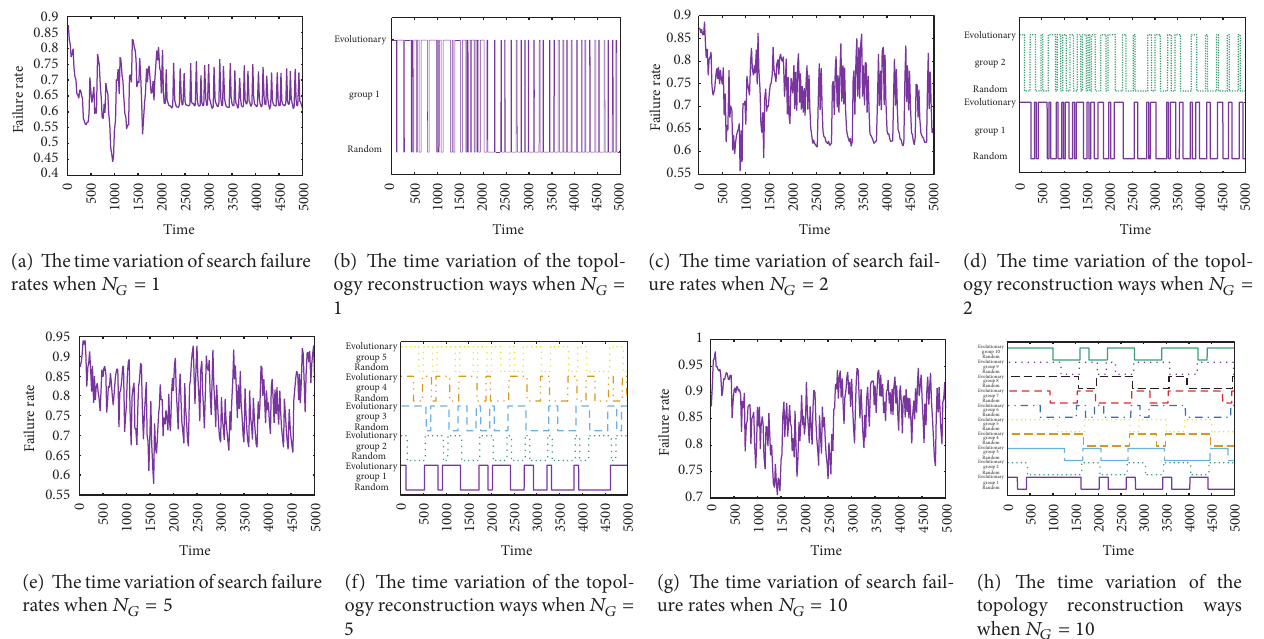
Figure 14: The result of one simulation run when using the simulation scenario that each node participates in the network with the probability randomly assigned in between 60% and 100% at every time and the environment dynamically changes. The time variations of search failure rates are drawn in the subfigures (a), (c), (e), and (g) and the time variations of the topology reconstruction ways are drawn in the subfigures (b), (d), (f), and (h). The time variation of the topology reconstruction ways is represented by a sequential line graph, in which drawing a line on the upper side stands for the use of the evolutionary reconstruction strategy and drawing a line on the lower side stands for the use of the random topology